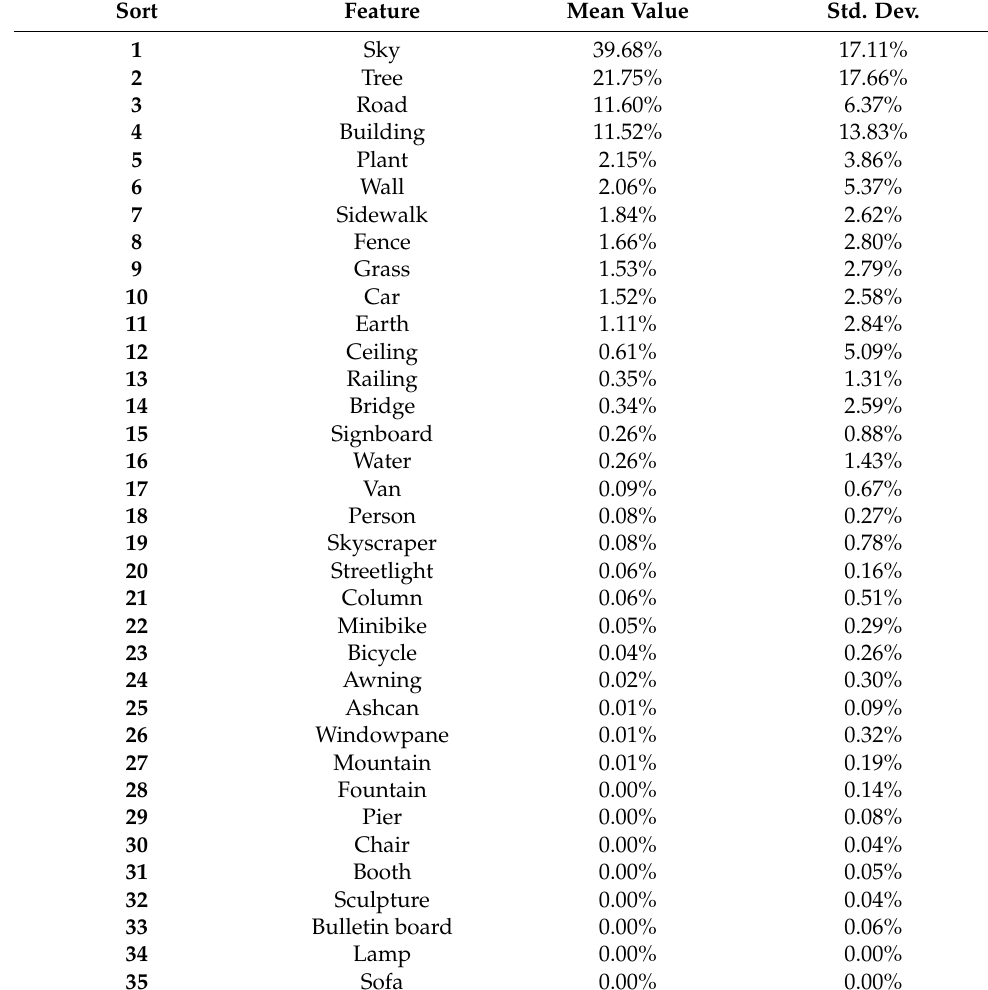
Table 3. Summary of the physical features extracted from the training street view images.